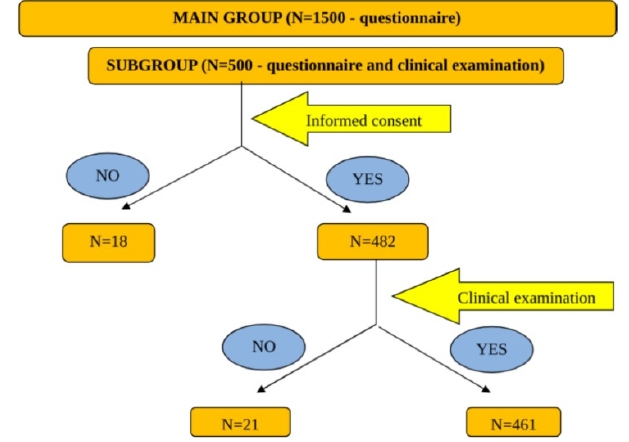
The diagnosis in psoriasis was a clinical one (observation of erythematous and squa- mous patches, generalized or localized in specific areas, itching, burning or soreness, thickened, pitted or ridged nails, swollen and stiff joints). During the medical consultation personal and family history and risk factors were also